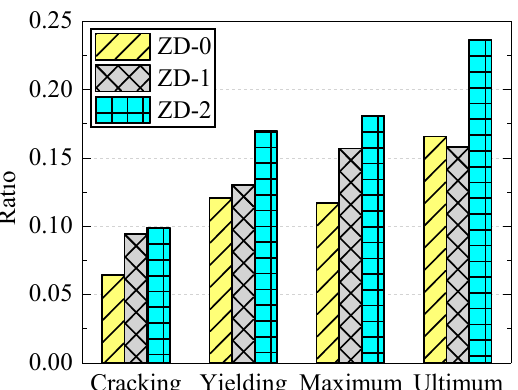
Figure 13. Contribution of shear displacement components to total lateral displacement.